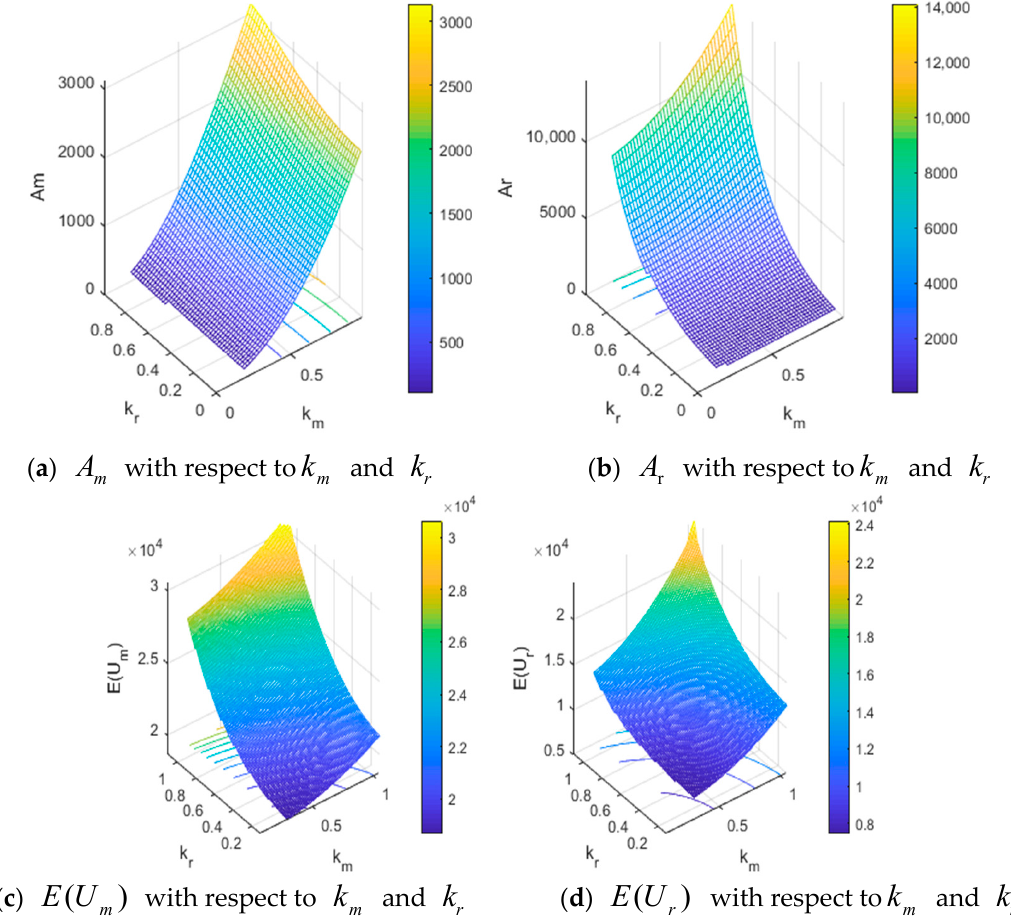
Figure 16. Nash equilibrium points and the expected utilities with α 1 = 3.5 α 2 = 3.5. Table 3. Nash equilibrium points ( A m , A r ) and expected utilities ( E ( U m ) , E ( U r )) with respect to k m and k r with α 1 = 3.5 and α 2 = 3.5 .